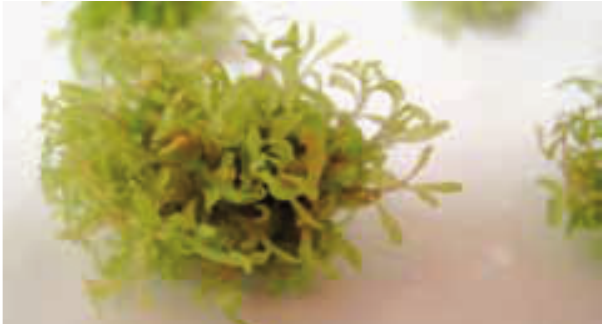
Fig. 2: Effect of best combination of growth regulators on in vitro proliferation of Atriplex halimus